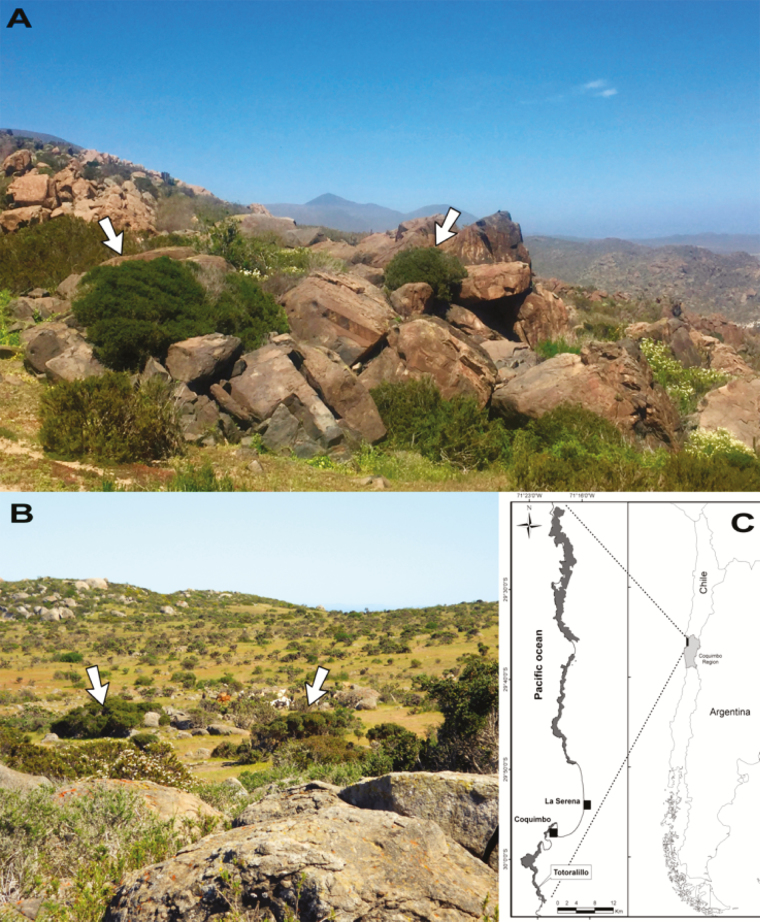
(A) Adult Myrcianthes coquimbensis shrubs growing from rock cavities; native rodents bury and/or hoard seeds into these cavities. (B) A typical landscape where M. coquimbesis is found; the arrows point to two M. coquimbesis monospecific stands. (C) Map showing the distribution (dark grey) of M. coquimbensis. The study site (Totoralillo) is located in the southern edge of its distribution. All photos were taken after the onset of the winter rains.